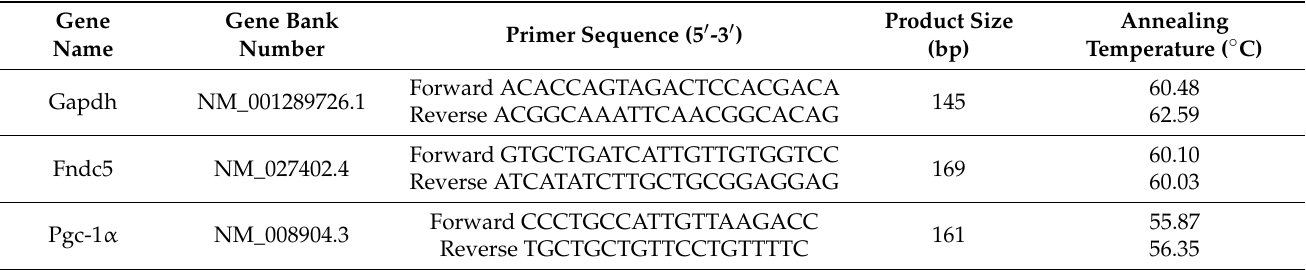
Table 3. Primer sequences used for quantitative real-time